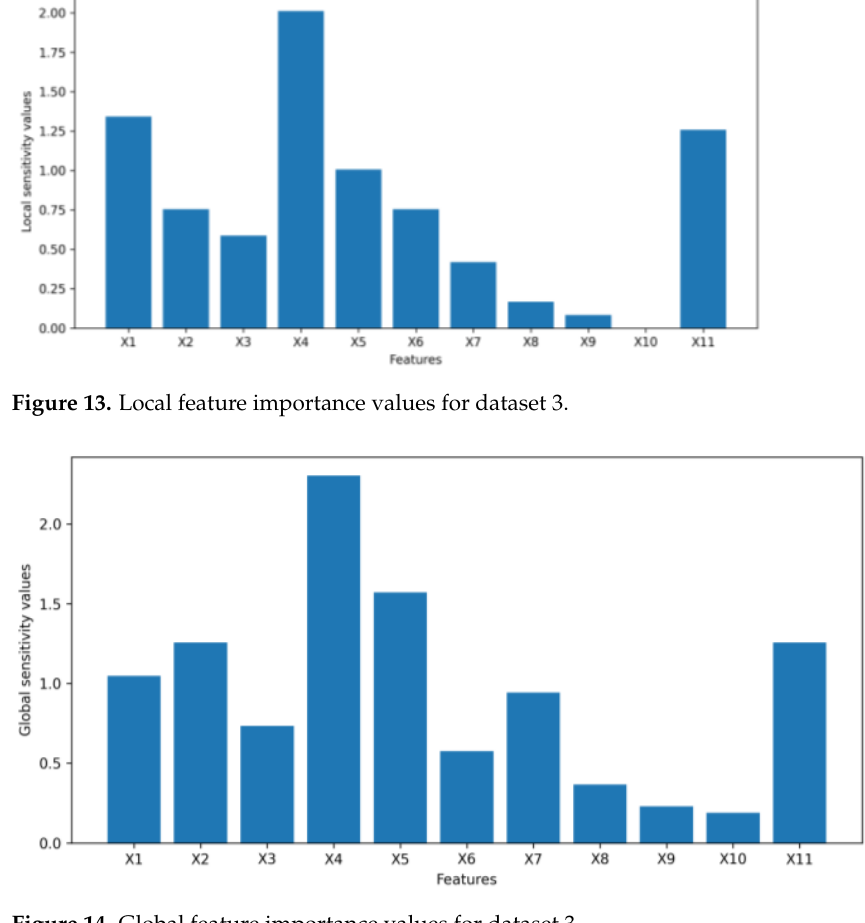
Figure 14. Global feature importance values for dataset 3.